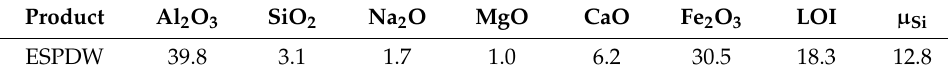
Table 2. The chemical composition of electrostatic precipitator dust after water leaching, wt. %.